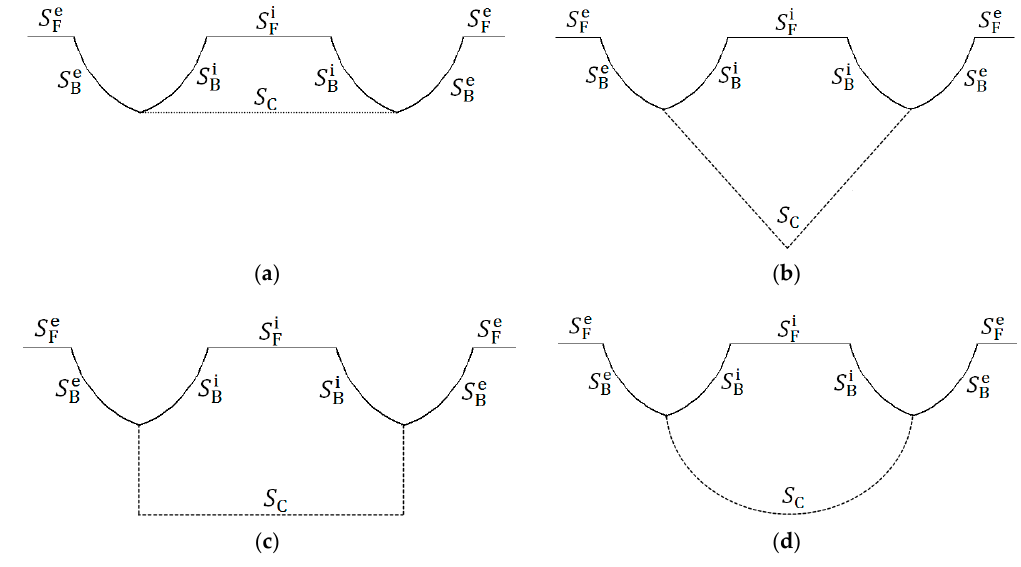
Figure 3. Various splitters for partitioning water domain around a transverse section of the Delft 372. ( a ) Straight splitter; ( b ) Triangular splitter; ( c ) Rectangular splitter; ( d ) Semicircular splitter.